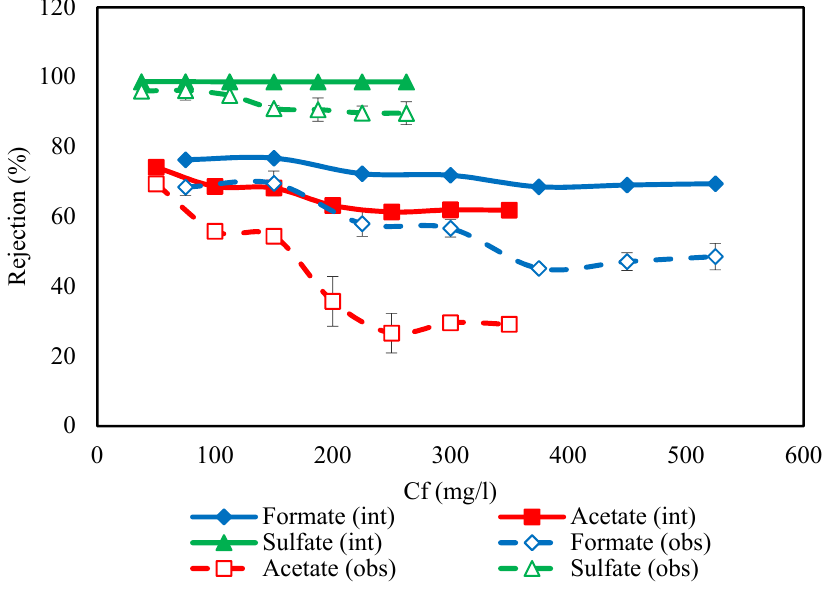
Figure 4. Comparison of observed and intrinsic rejection for acetate, formate, and sulfate in the NF-3 membrane at 35 °C and 70 bar.